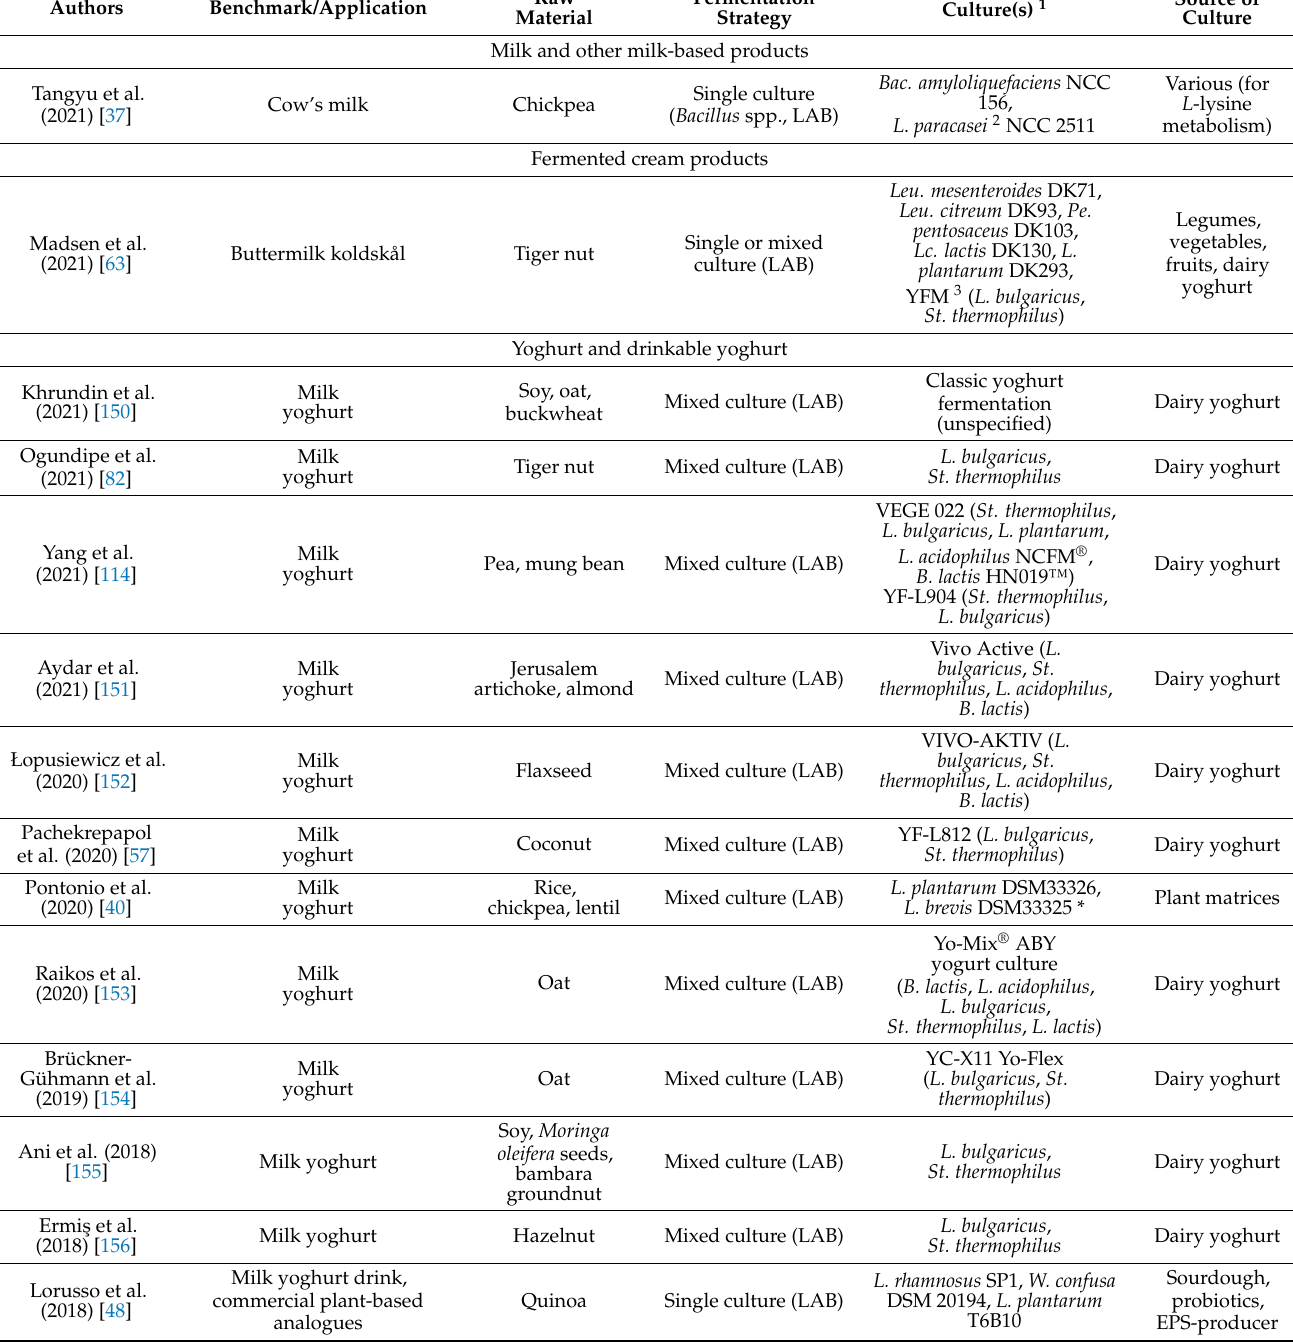
Table 4. Selected studies in the past ten years (2012 to date) applying fermentation as a strategy to improve the organoleptic properties of plant-based dairy